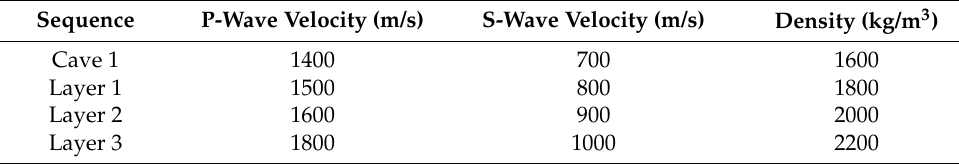
Table 3. Elastic parameters of the model